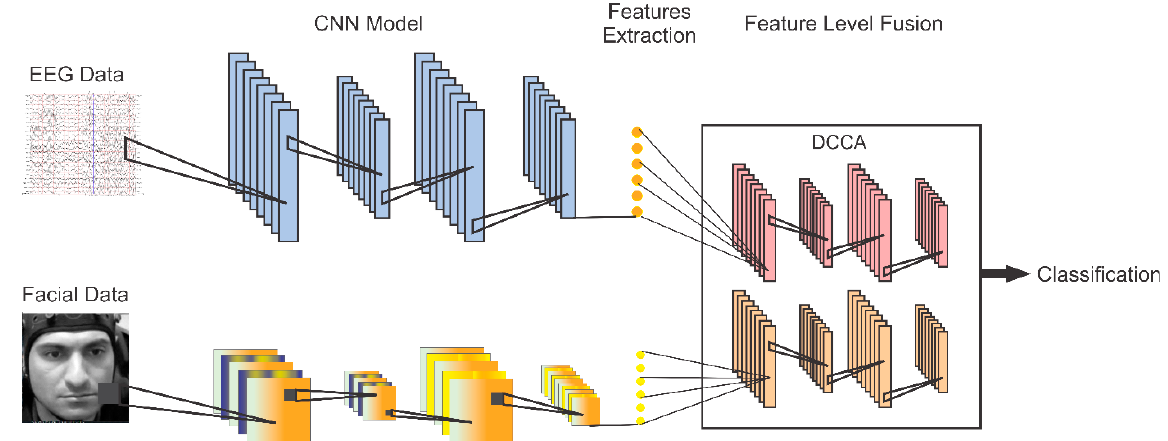
Figure 2. Proposed model for emotion recognition using EEG and facial video clips (the facial image adopted from [63]).